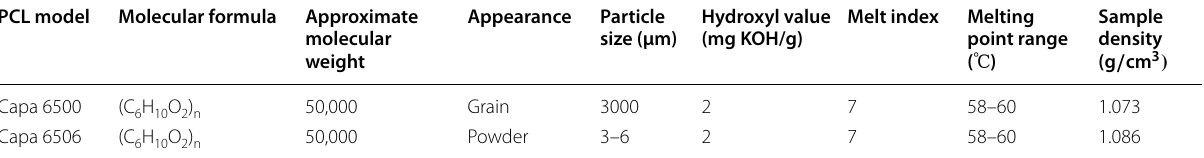
Table 1 Basic technical indicators of PCL. PCL